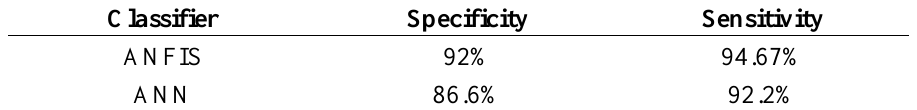
Table 7. Performance comparison between ANFIS- and ANN-based methods